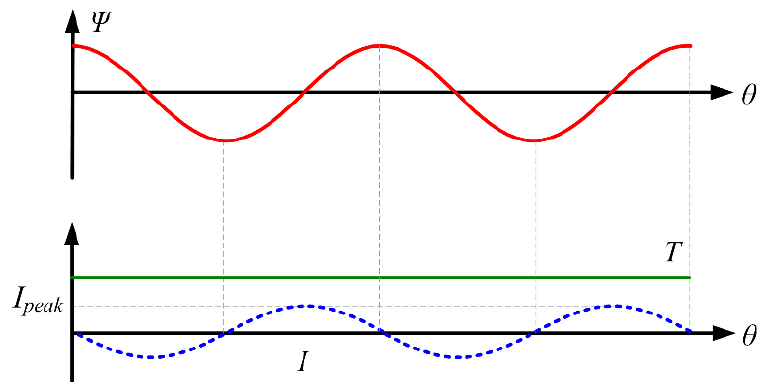
Figure 3. Brushless AC conduction scheme. Armature current I ; flux-linkages Ψ ; resultant torque T .